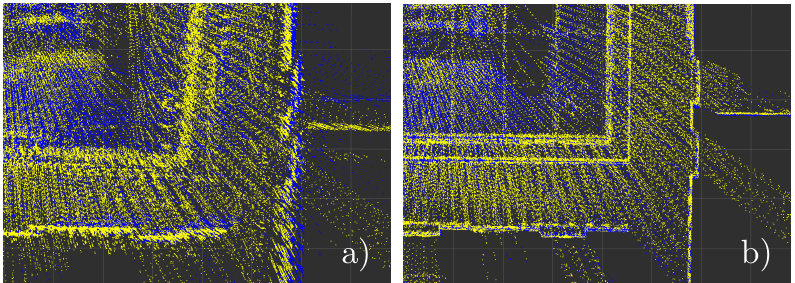
Figure 1. Top-down view on a LiDAR scan of a building. ( a ) shows erroneous and ( b ) the correct transformed point cloud